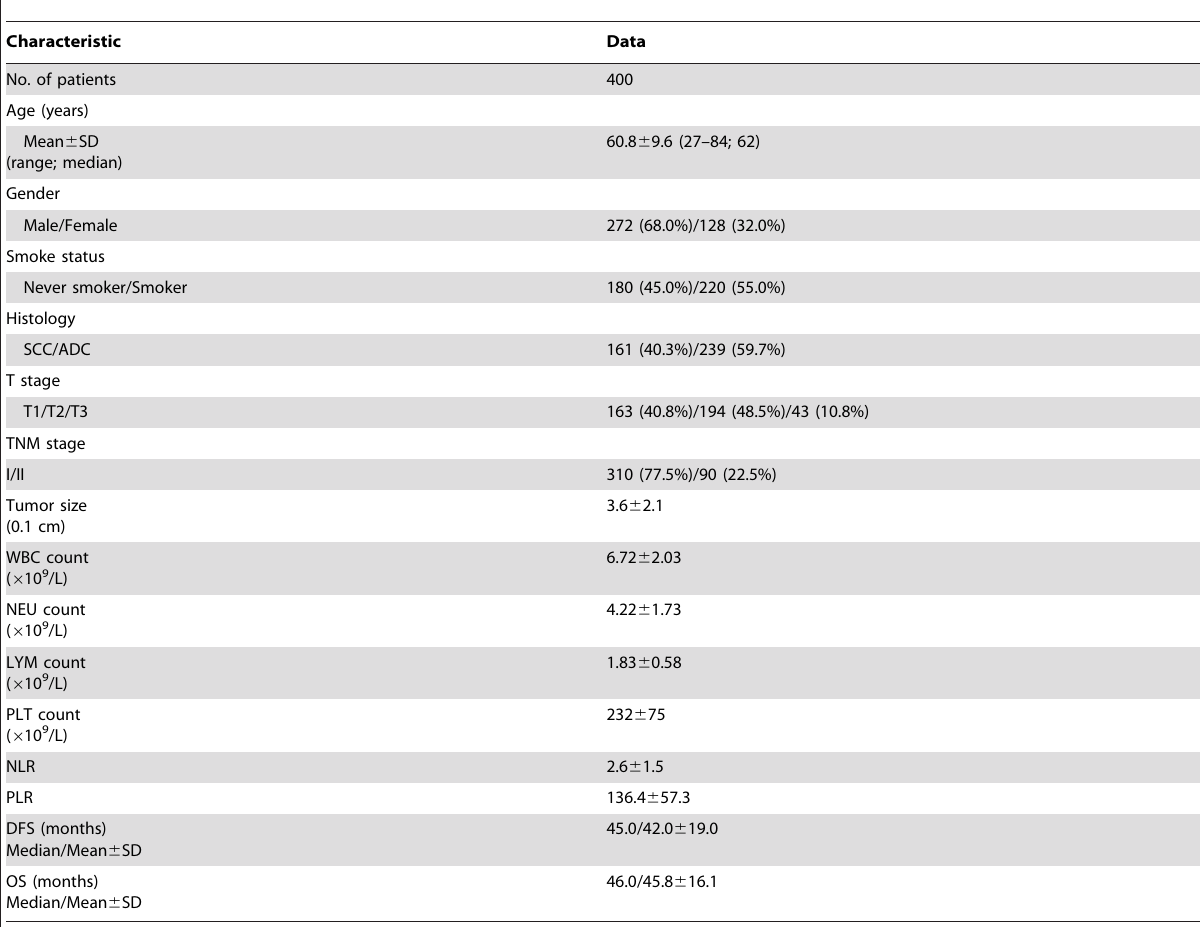
Table 1. Clinical characteristic of all 400 lung cancer